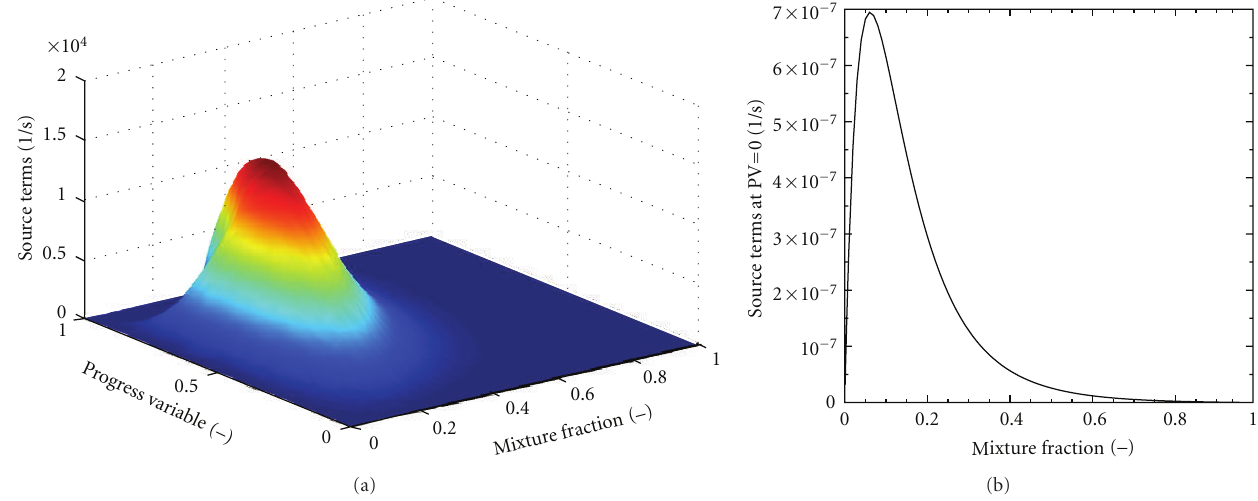
Figure 1: (a): progress variable source term ˙ ω Y c versus mixture fraction Z and normalized progress variable PV for Case 0 computed with ´O Conaire mechanism. (b): initial PV source term (PV = 0 . 0). Boundary conditions: Case 0 described in Table